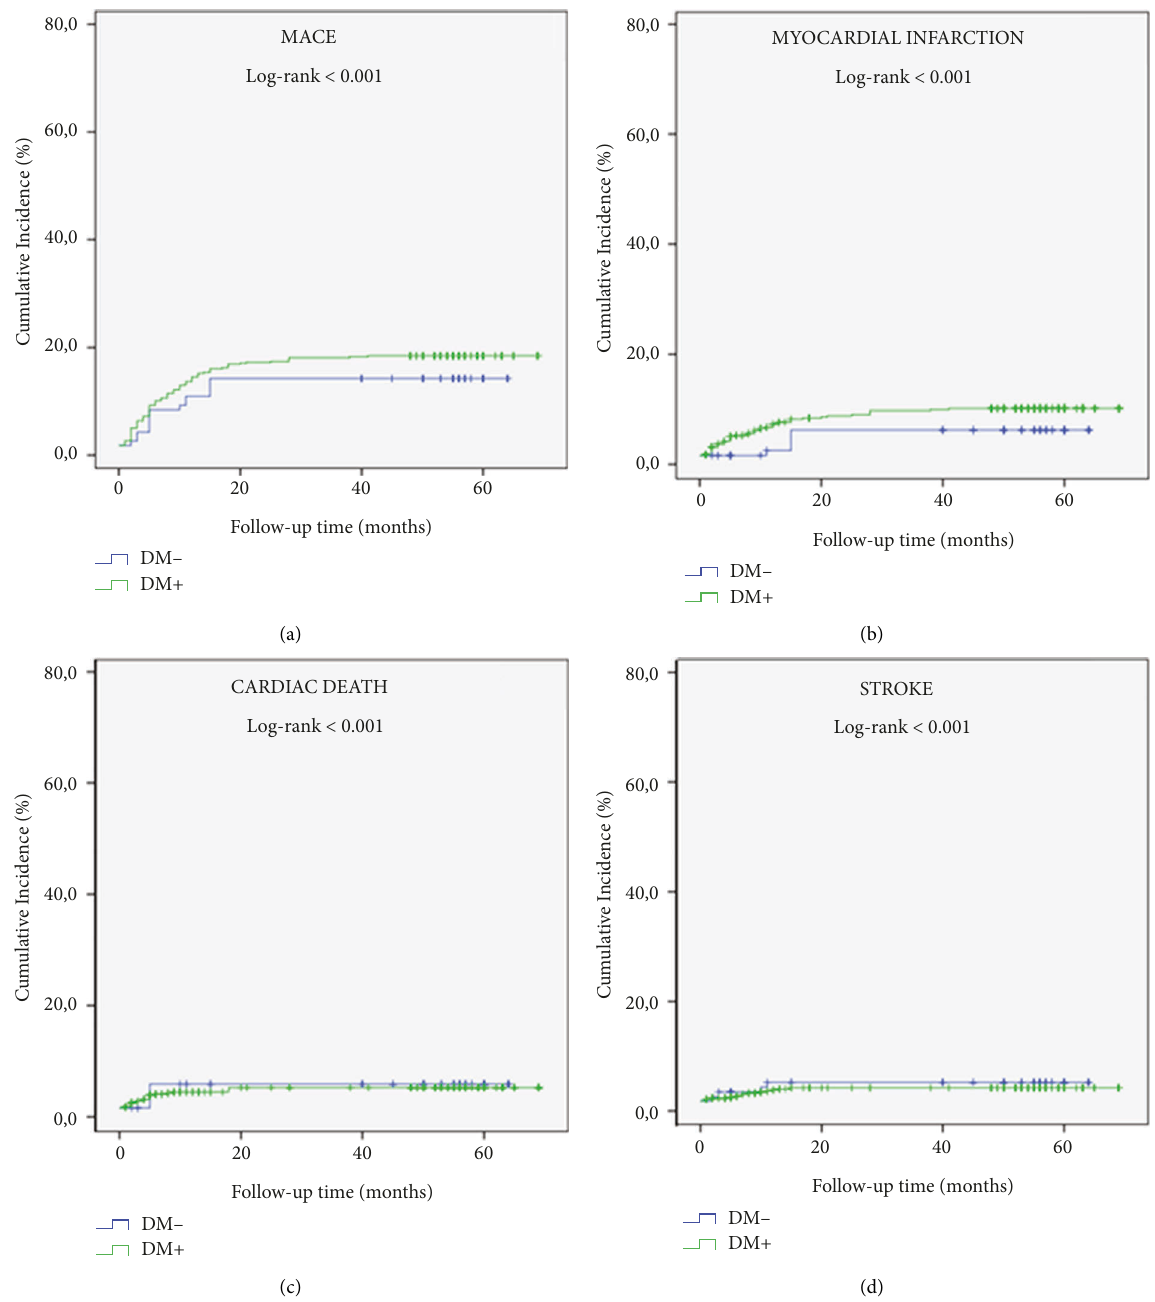
Figure 7: Kaplan–Meier curves showed similar risks of MACE (a), myocardial infarction (b), cardiac death (c), and stroke (d) among the DM group and non-DM